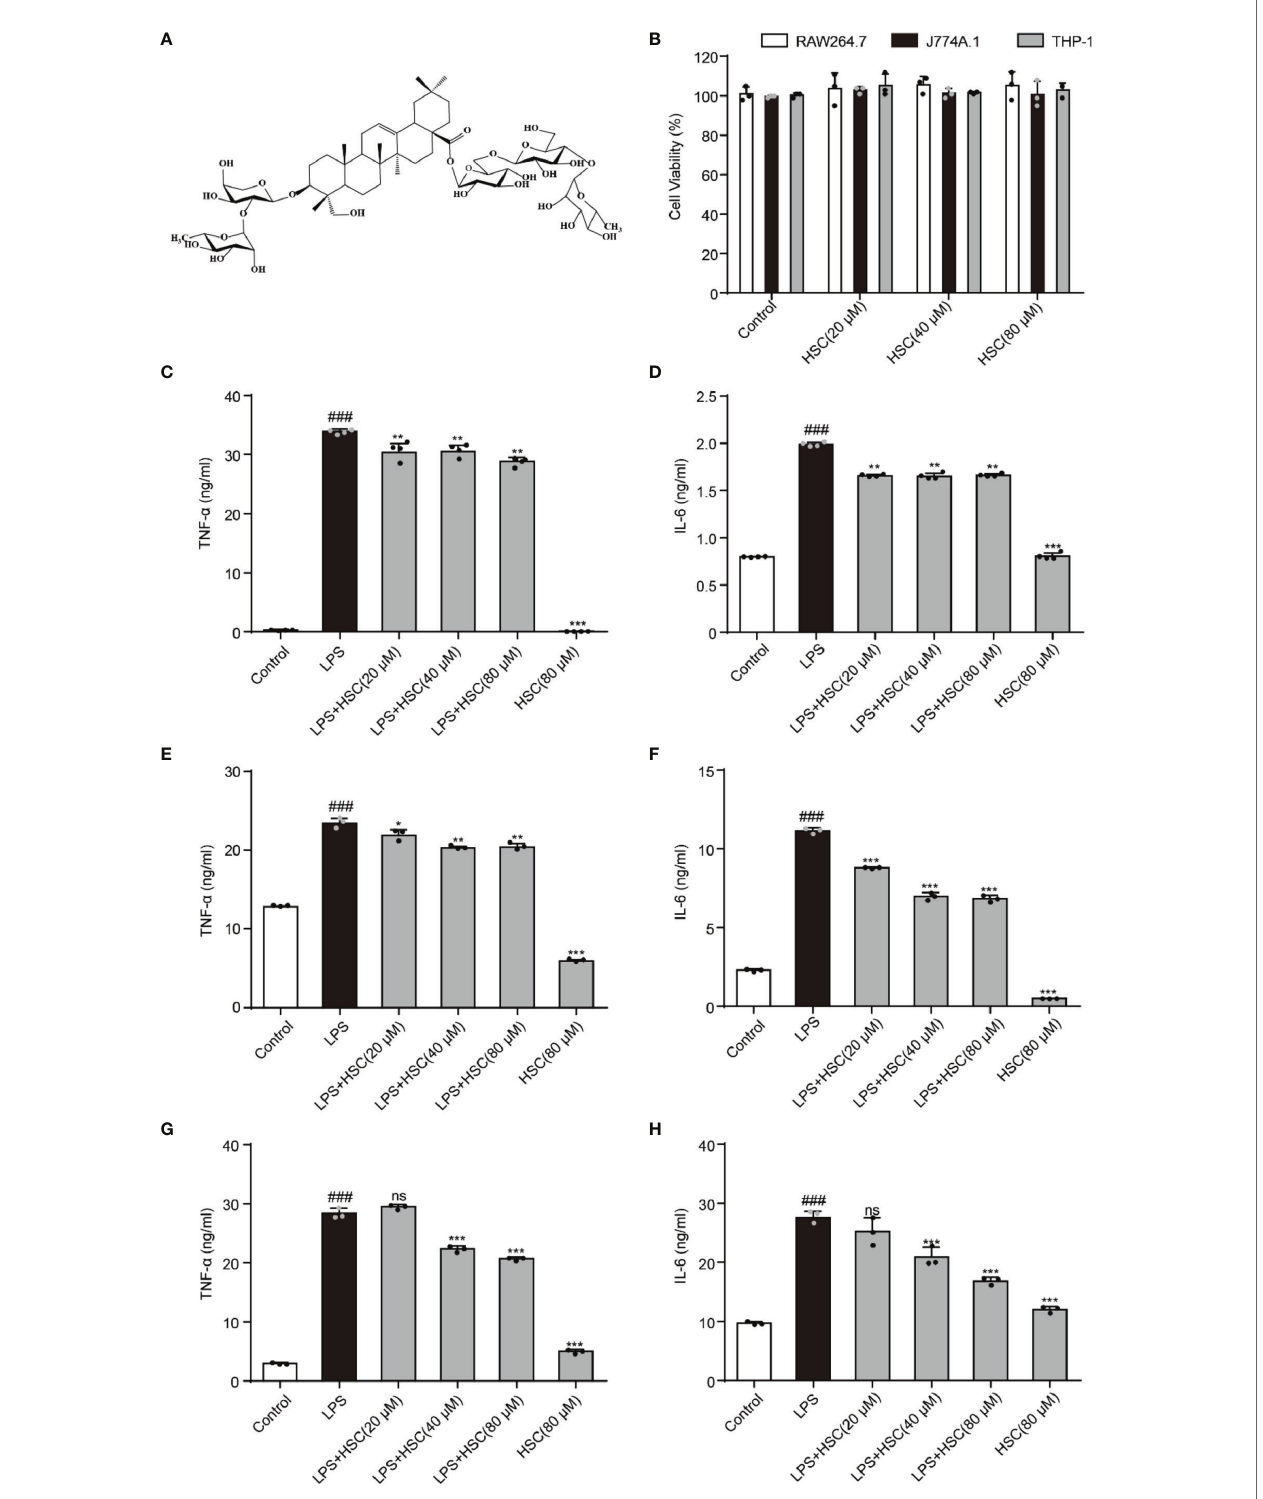
FIGURE 1 | HSC regulates LPS-induced pro-in fl ammatory transcription. (A) The chemical structure of HSC; (B) RAW264.7, J774A.1, and THP-1cells were treated with HSC for 24 h, and cell viability was determined by the MTT assay; RAW264.7 (C, D) , J774A.1 (E, F) , and THP-1 (G, H) cells were treated with HSC for 4 h before co-incubation with LPS (1 m g/ml) for 18 h, the expression of TNF- a and IL-6 was detected using ELISA kits; ### P < 0.001 compared to control alone group; * P < 0.05, ** P < 0.01, and *** P < 0.001, compared to LPS alone group, ns, no signi fi cance